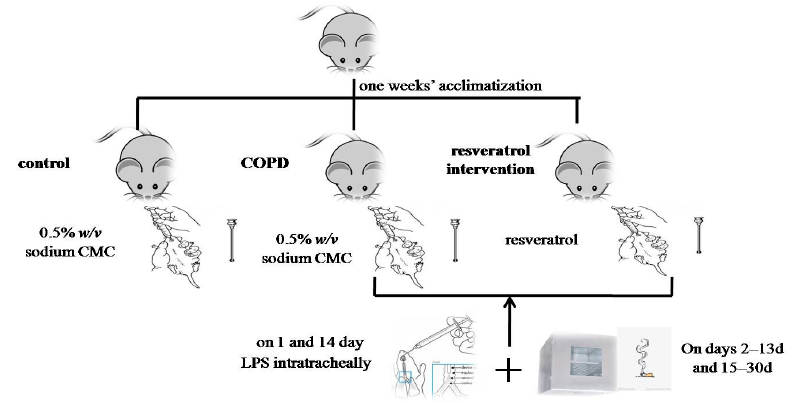
Figure 8. Schematic diagram of animal models.